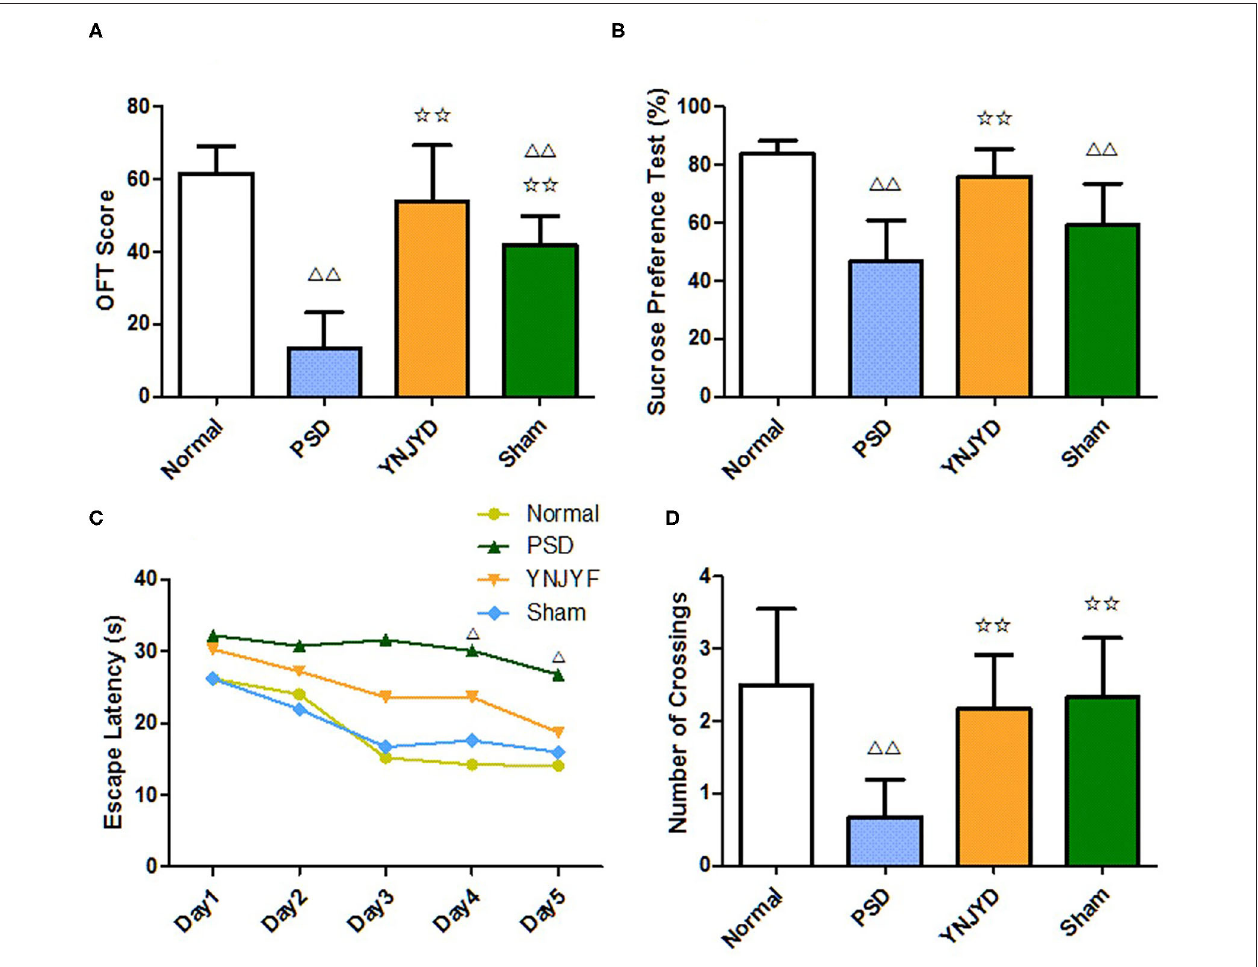
FIGURE 3 | Effects of yi-nao-jie-yu decoction (YNJYD) on depressive-like behaviors in normal and post-stroke depression (PSD) model rats. (A) The open field test (OFT) scores, quantified from the sum of the crossing times and rearing times. (B) Percentages for the sucrose preference testing (SPT). (C) Escape latency in the Morris water maze (MWM) test. (D) The number of platform crossings in the MWM test. The data are presented as means ± SD. 1 P < 0.05 vs. normal; 11 P < 0.01 vs. normal; 99 P < 0.01 vs.